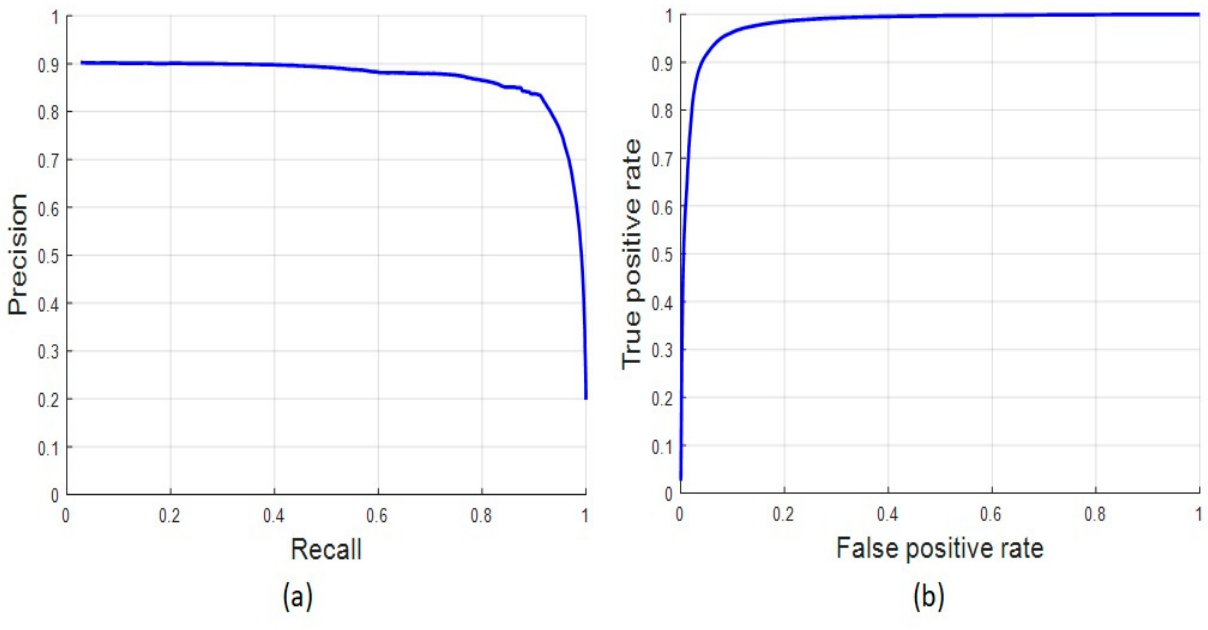
Figure 7. ( a ) Receiver operator characteristics (ROC) curve ( b ) Precision-recall (PR) curve of the proposed approach.